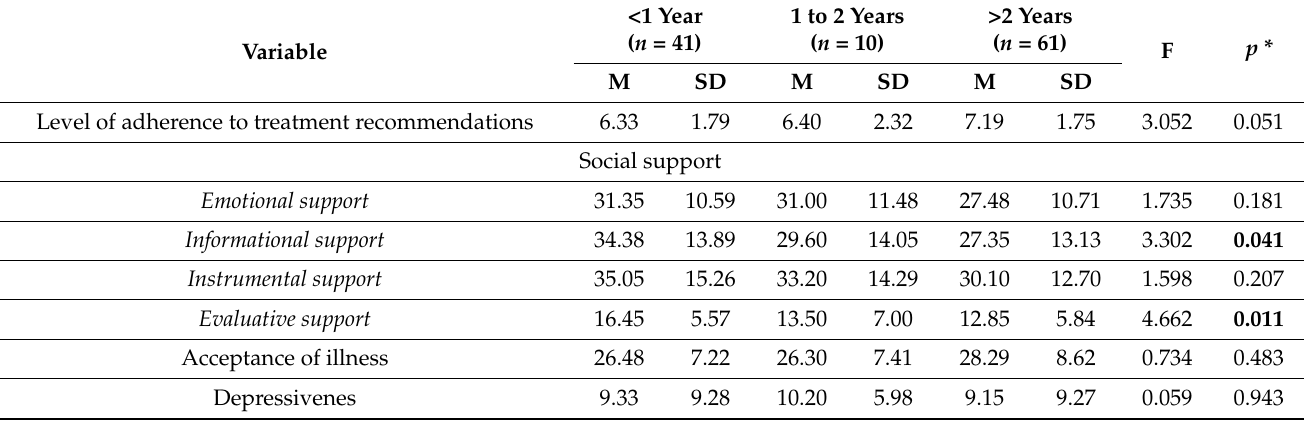
Table 7. The level of treatment adherence, social support according to the ISSB, disease acceptance according to the AIS, and depressiveness according to the BDI among liver transplant patients by the time since liver transplantation.